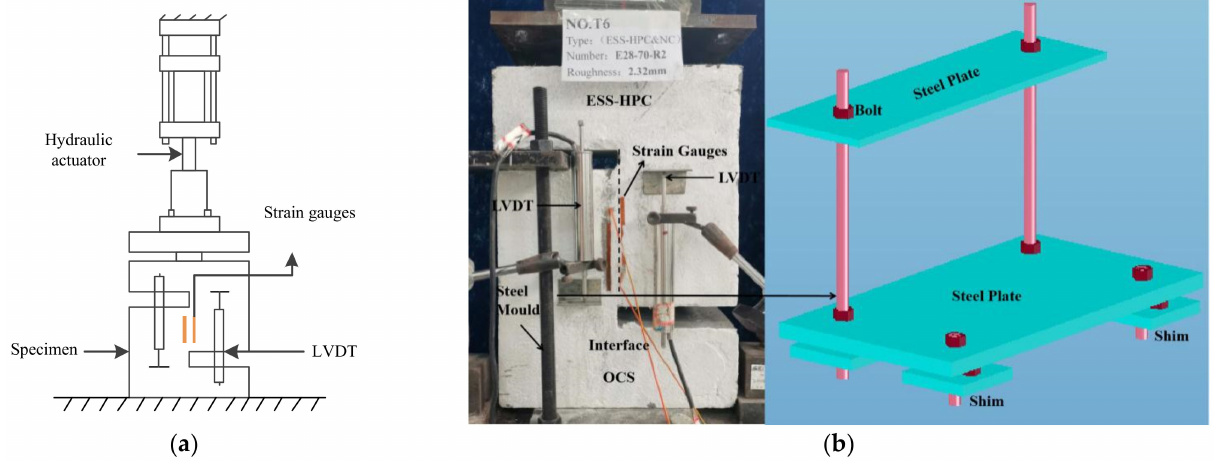
Figure 5. Testing setup. ( a ) Direct shear test; ( b ) steel